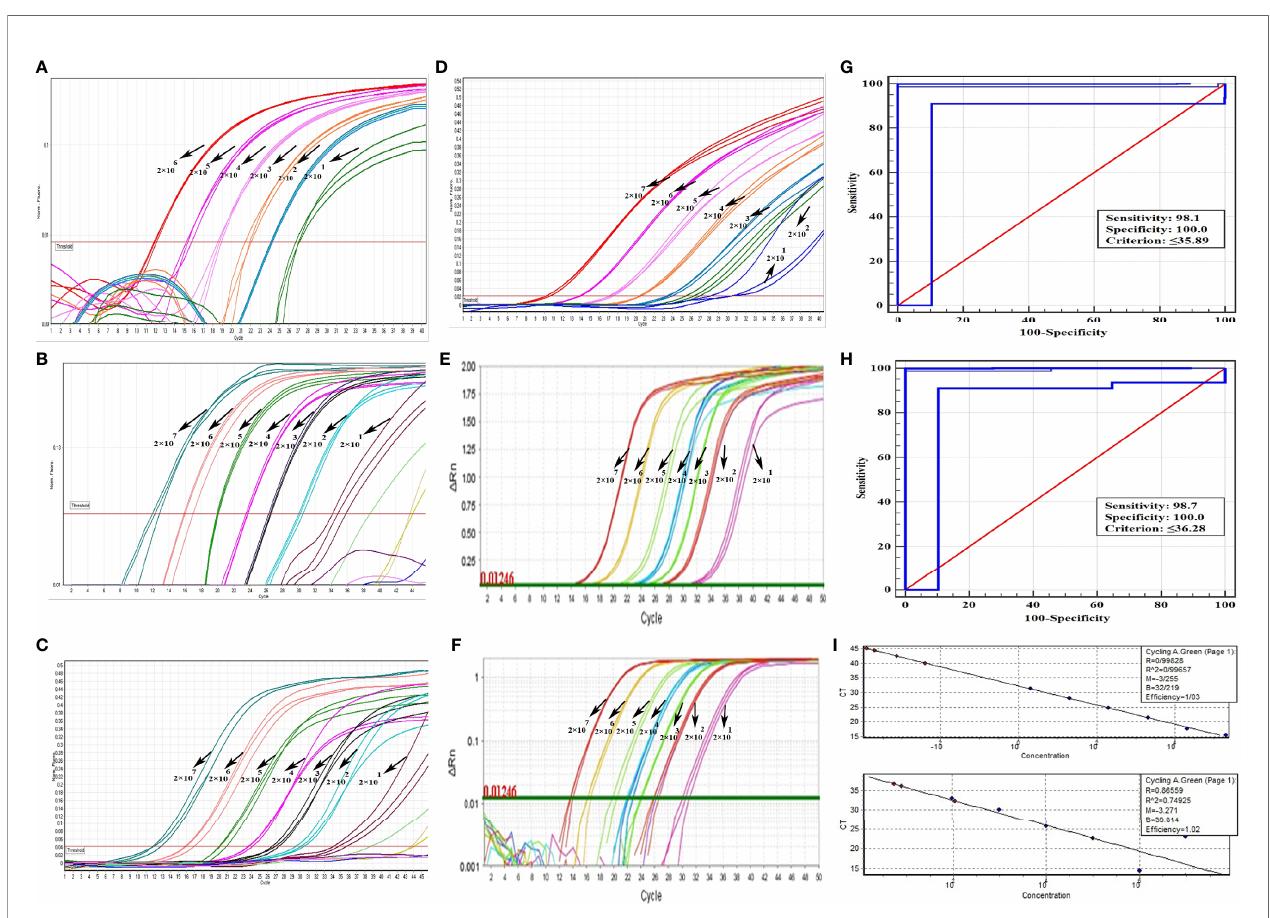
FIGURE 3 | Performance speci fi cations of Leishmania detection with qPCR validation. Ampli fi cation plots derived from serial dilutions of cultured parasites, ranging from 20 to 2 × 10 7 copies/rxn plasmids by qPCR. FAM fl uorescent reporter dye of COII gene, compared to Cyt b (FAM fl uorophore) in the reference kit was displayed. (A) Reportable range of Leishmania (20 – 2 × 10 6 ). (B, C) Logarithmic and linearity ampli fi cation plots of detection limit of Leishmania (20 – 2 × 10 7 ) using COII, respectively. (D) Linearity ampli fi cation plot of detection limit of Leishmania using Cyt b in reference kit. (E, F) Linearity and logarithmic ampli fi cation plot of quanti fi cation limit of reproducibility using StepOnePlus ™ machine, respectively. Ampli fi cation curves are shown for each sample, with each parasite concentration depicted by different color. (G) Clinical sensitivity and speci fi city of Leishmania diagnostic by ROC analysis (sensitivity = 98.1, diagnostic CT = 35.89) using COII. (H) Clinical sensitivity and speci fi city of Leishmania with genesig ® Leishmania Advanced diagnostic kit (sensitivity = 98.7, diagnostic CT = 36.28) using Cyt b (I) Standard quanti fi cation curves, the mean CT values are plotted from triplicates tested against prepared serial dilutions. Each point represents CT of an individual sample, with plot of CT values and parasite equivalent fi tting a linear function (R 2 = 0.996 for qPCR and, R 2 = 0.749 for genesig ® Leishmania Advanced kit) (See Table 2